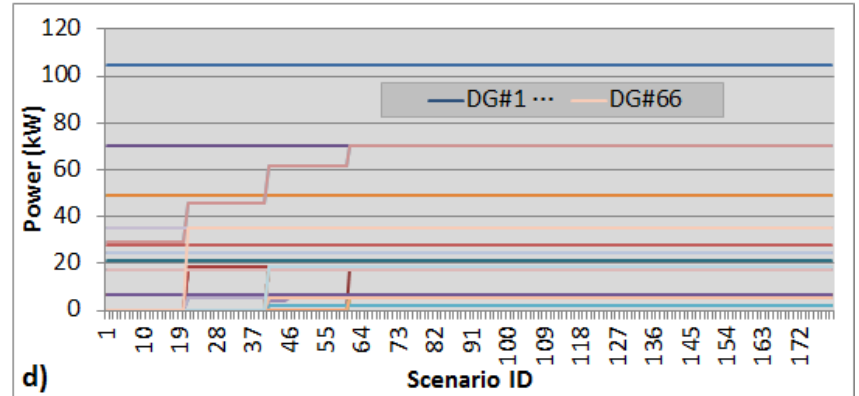
Figure 4. Resources scheduling in each scenario: ( a ) Each of the 32 DR resources in energy production; ( b ) Each of the 32 DR resources in reserve production; ( d ) Each of 66 DG resources in energy production. Scenario parameters variation ( c ); generation price, required reserve, reserve use probability— pr .